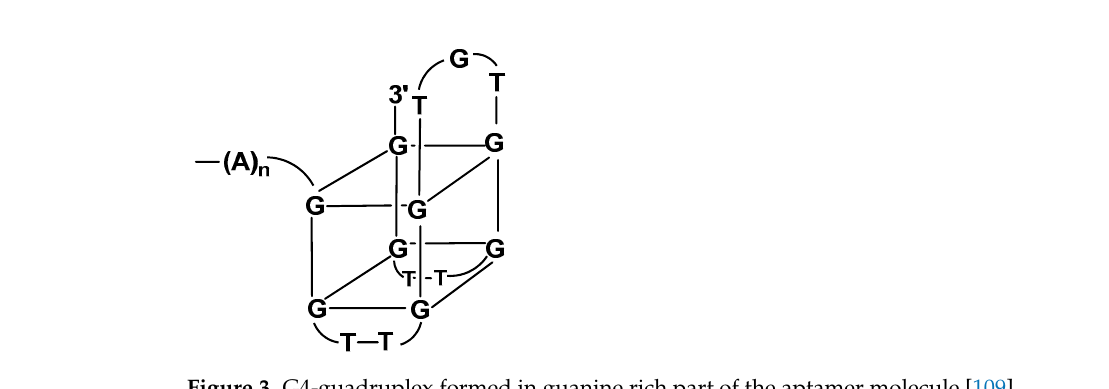
Figure 3. G4-guadruplex formed in guanine rich part of the aptamer molecule [109]. Pinhole, also named hairpin or stem-loop aptamers, contain pseudo-circle areas that are separated with self-hybridized double-stranded fragments. The structures selected from random libraries are presented in Figure 4 [110]. The number of unhybridized “circles” can vary from one to four. In a recognition event, some of the “circles” are opened to a linear configuration and are bonded to the analyte molecule [111]. This results in dramatic changes to the specific charge and volume of the aptamer molecule. Moreover, terminal groups introduced for electrochemical/optical detection change their relative position. Chemosensors 2021 , 9 , x FOR PEER REVIEW